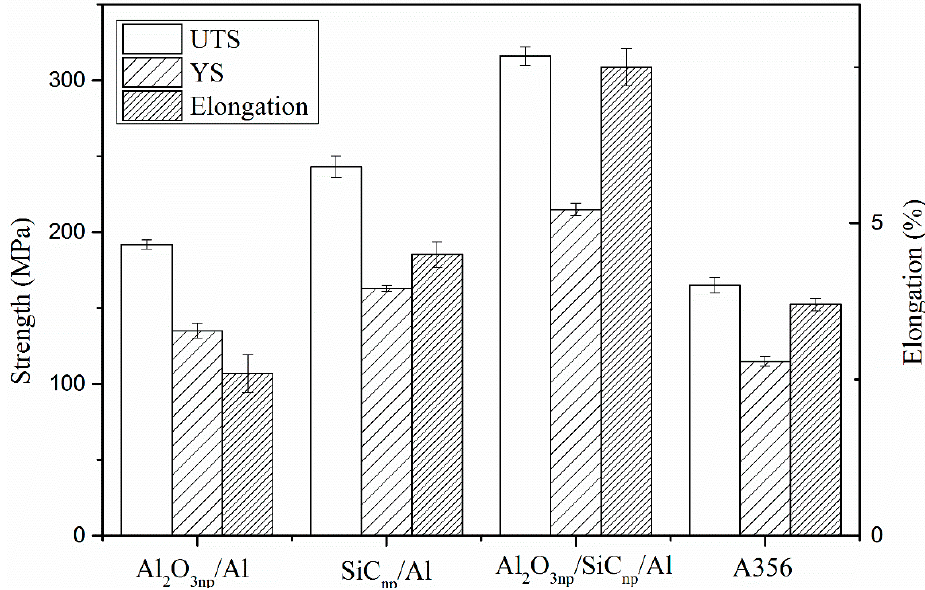
Figure 7. The strength and elongation of nanocomposites and the matrix alloy .